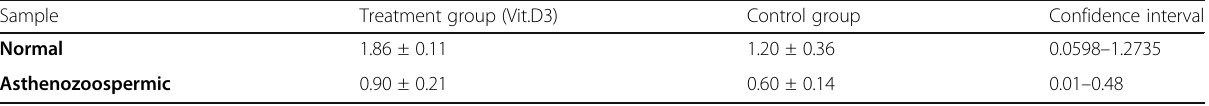
Table 3 Mean of optical density of HSP70 protein from samples after incubation with Vit.D3